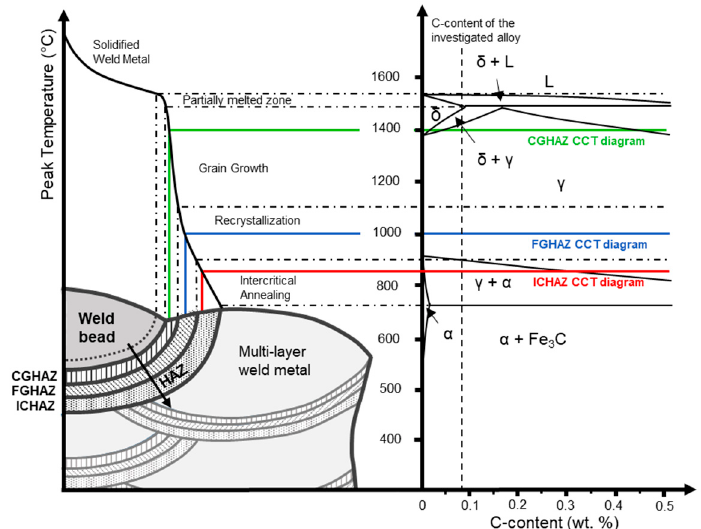
Figure 2. Schematic drawing of the different areas within the HAZ between the weld beads in a multi-layer weld metal and the corresponding peak temperatures for low alloyed weld metal with low C-contents according to G. Schulze [8]. The peak temperatures chosen for the CGHAZ, the FGHAZ and the ICHAZ welding CCT diagram are highlighted with green, blue and red lines.